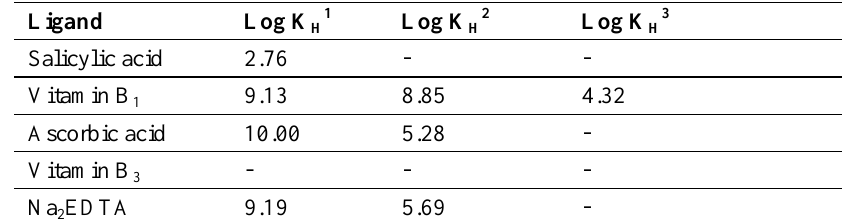
Table 1 : Protonation constants of ligands.